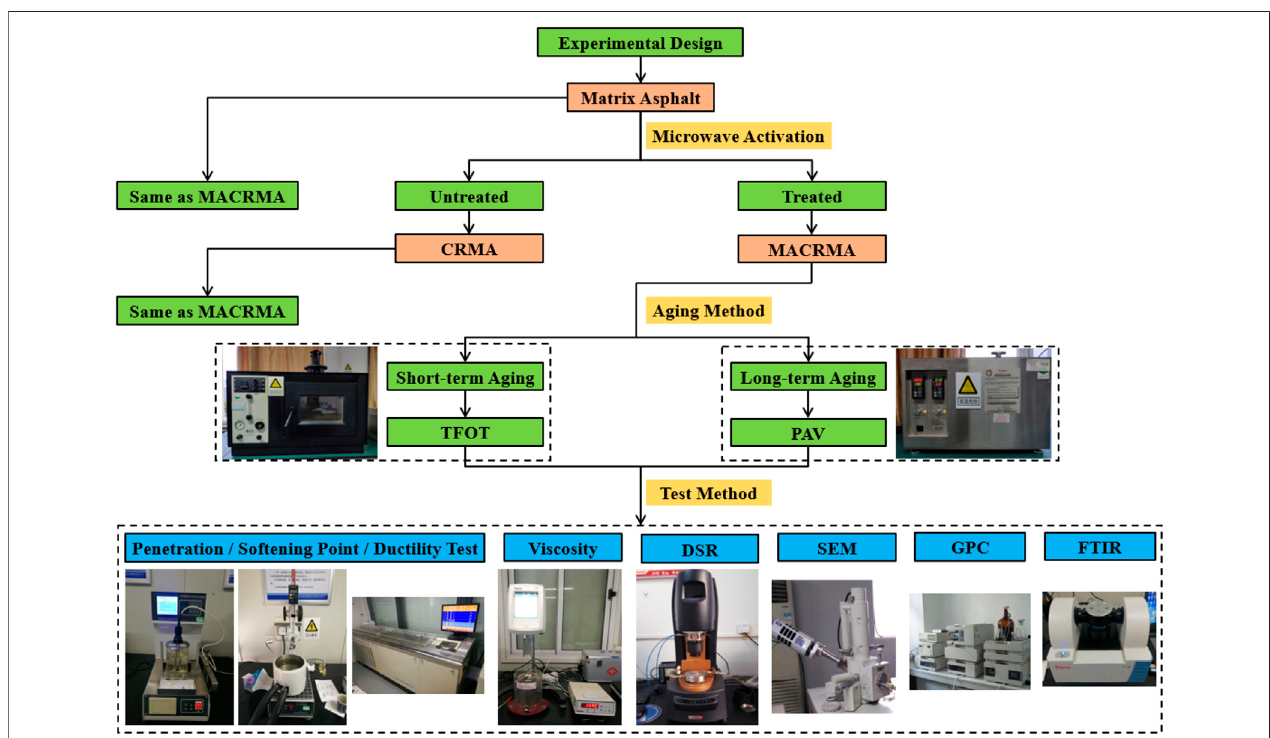
FIGURE 3 | Experimental design and research methods.